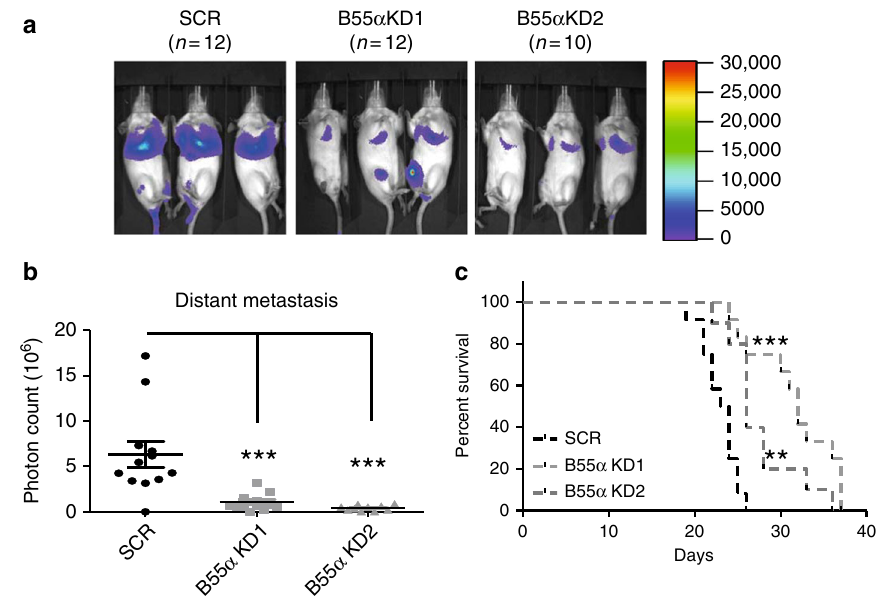
Fig. 7 Knockdown of B55 α decreases breast cancer metastasis. a Representative bioluminescent images of metastatic burden in mice at 3 weeks after injection is shown. b Quanti fi cation of photon fl ux in a , p -value is calculated using one-way ANOVA followed by Tukey test, *** p < 0.001. c Kaplan – Meier curves demonstrate the percentage of mice that survived, p -value is calculated using a log-rank test followed by Bonferroni correction, ** p < 0.01, *** p <